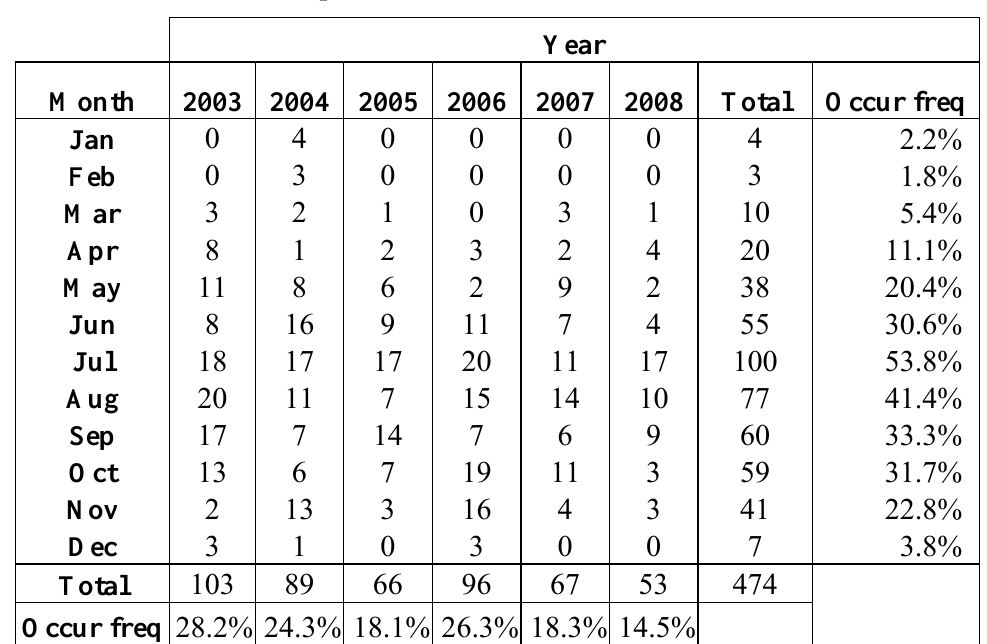
Table 1. Number of the cold patch detected from SST in the months from 2003 to